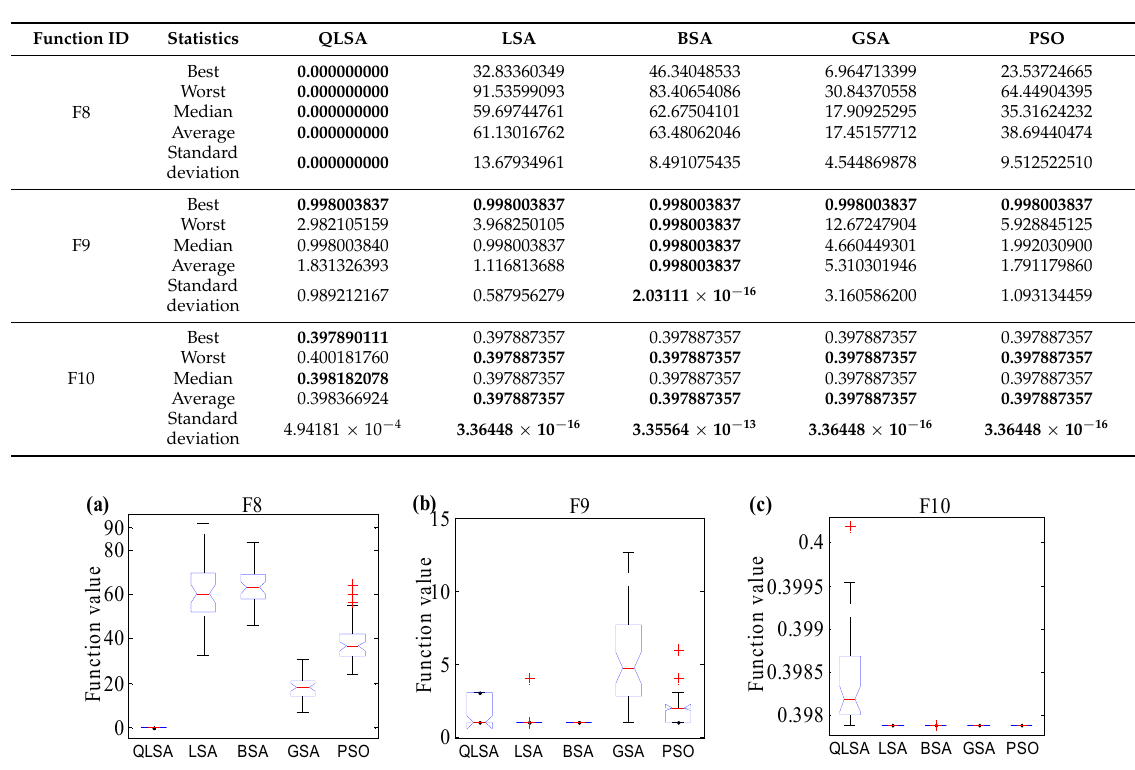
Table 8. Test 3 global optimization results for benchmark functions in Table 7.